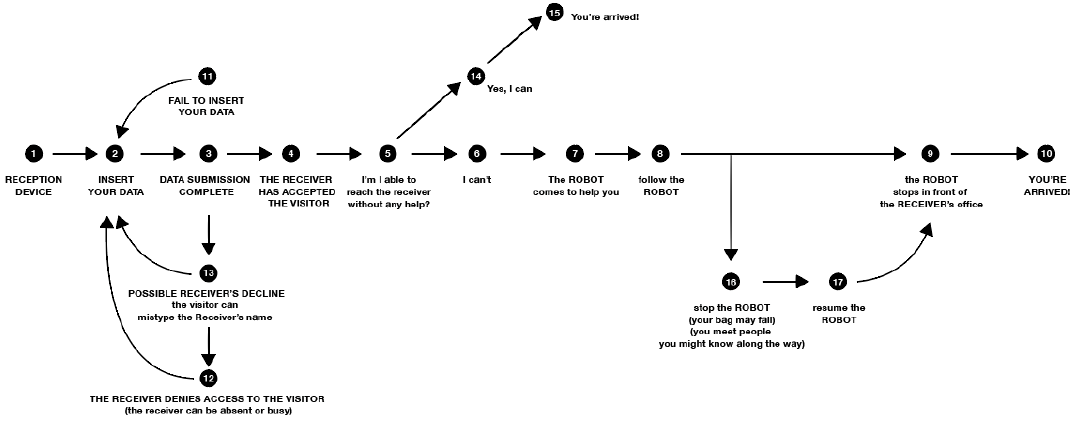
Figure 2. The user experience storyboard involving the Visitor and Receiver characters.